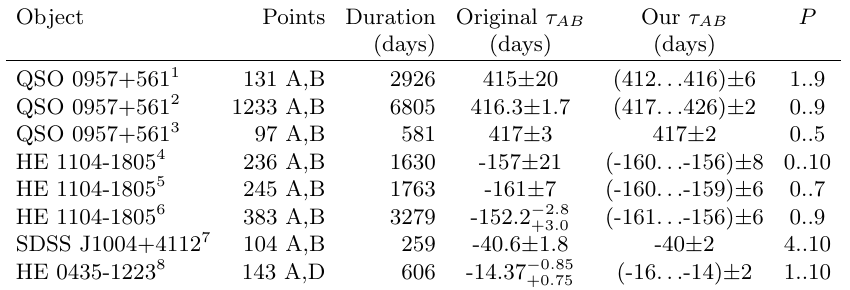
Table 1. Datasets and